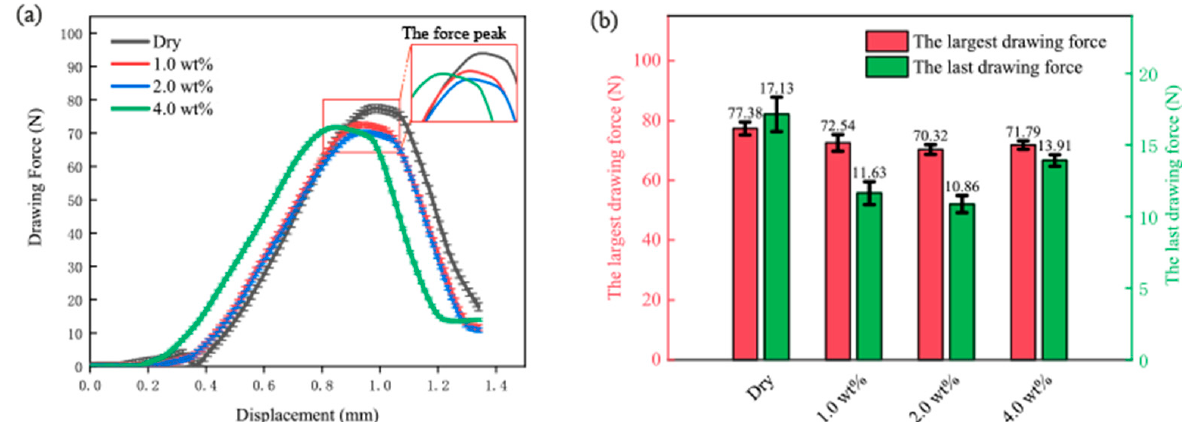
Figure 7. ( a ) Drawing force-displacement curve under different lubrication conditions; and ( b ) the largest and last drawing force under different lubrication conditions.